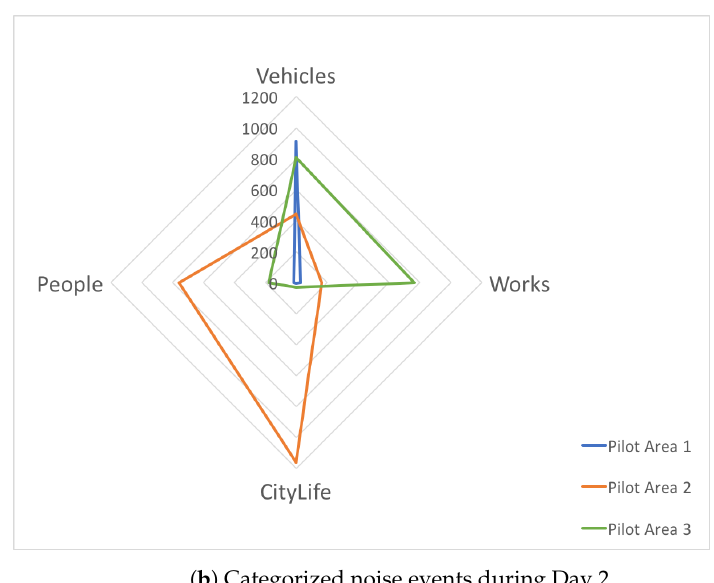
Figure 4. Radar graphs comparing the four defined noise categories, in terms of number of occurrences of each event in each category.